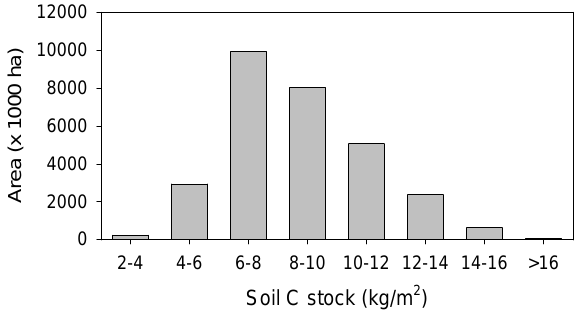
Fig. 2. Distribution histogram of SOC stocks for the covered area.